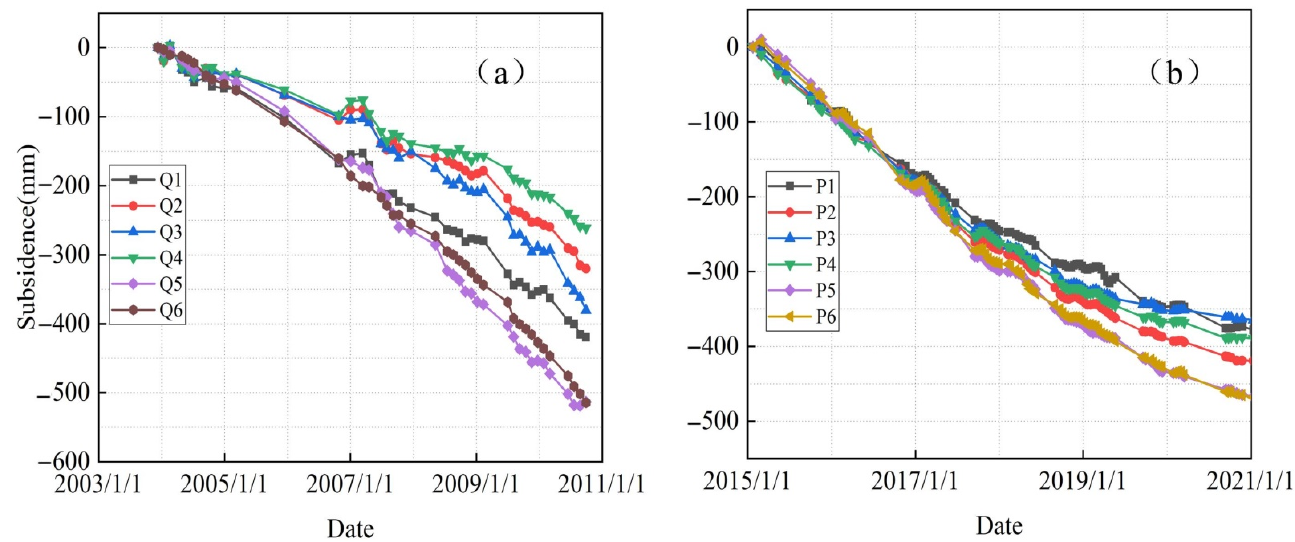
Figure 6. Time-series deformation of typical feature points from ( a ) 2003–2010 and ( b ) 2015–2020.